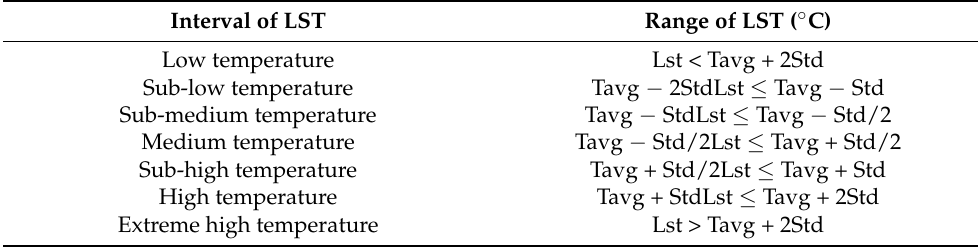
Table 4. Rules for dividing the intervals and ranges of land surface temperature (LST) into seven categories for both study areas, adapted from [3]. Interval of LST Range of LST ( ◦ C) Low temperature Lst < Tavg + 2Std Sub-low temperature Sub-medium temperature Medium temperature Sub-high